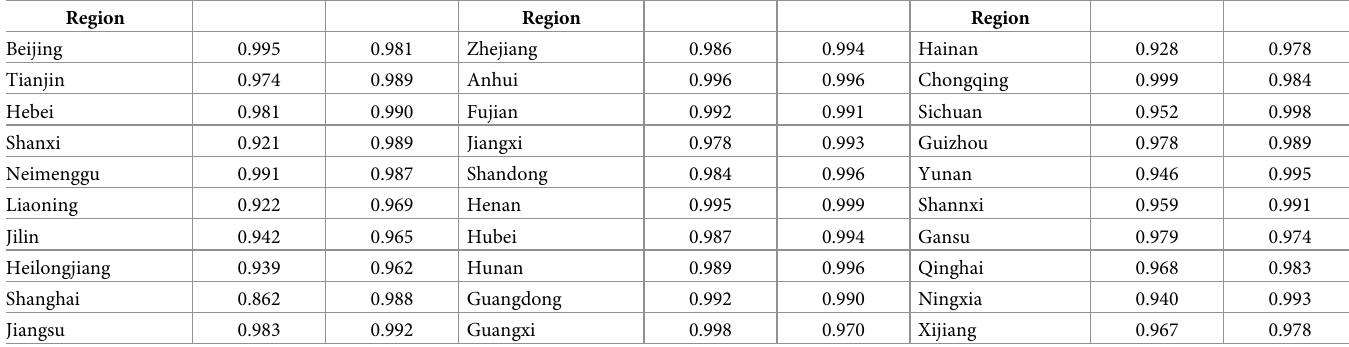
Table 4. Fitness values of coupling model of provincial high-tech industry and regional economic subsystems from 2006 to 2016.